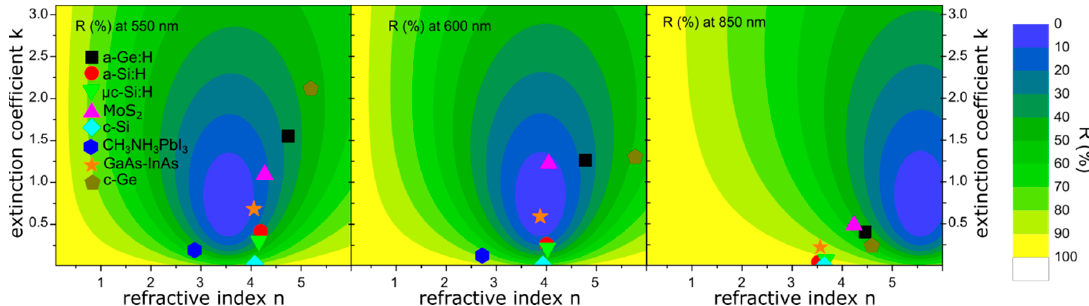
Figure 2. Influence of refractive index n and extinction coefficient k on the reflection of a 20 nm thick absorber layer on 300 nm Ag. The reflection has been calculated at three different wavelengths. The data points from literature for MoS 2 [19], c-Si [20], Perovskite (CH 3 NH 3 PbI 3 ) [21], GaAs-InAs [22], and c-Ge [23], as well as from fitted experimental data for a-Ge:H, a-Si:H, and µc-Si:H are included in the plot.